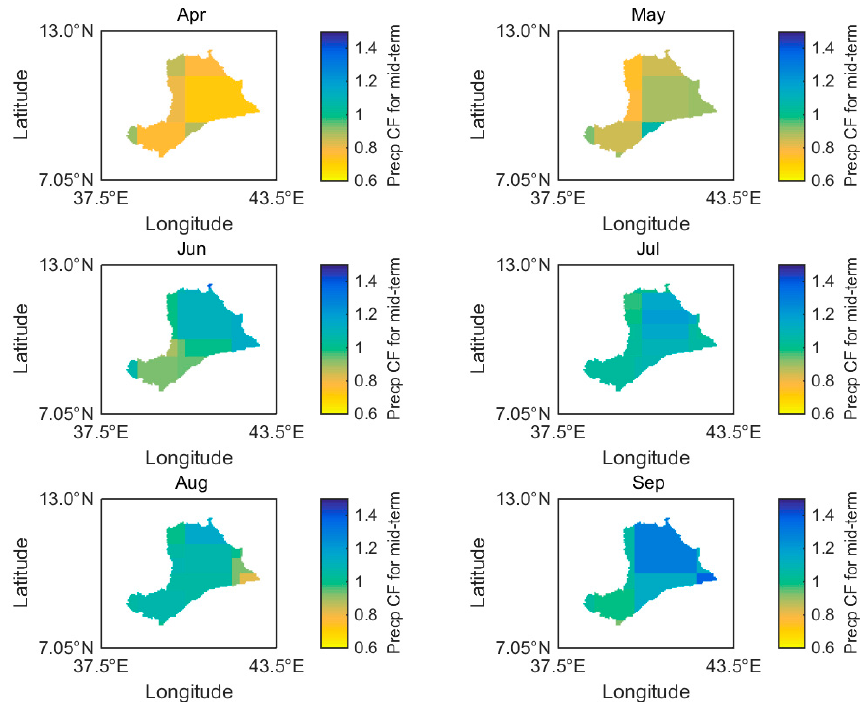
Figure 7. Precipitation change factors for April to September months for the mid-term period, 2031–2055 (based on the median of the three models).